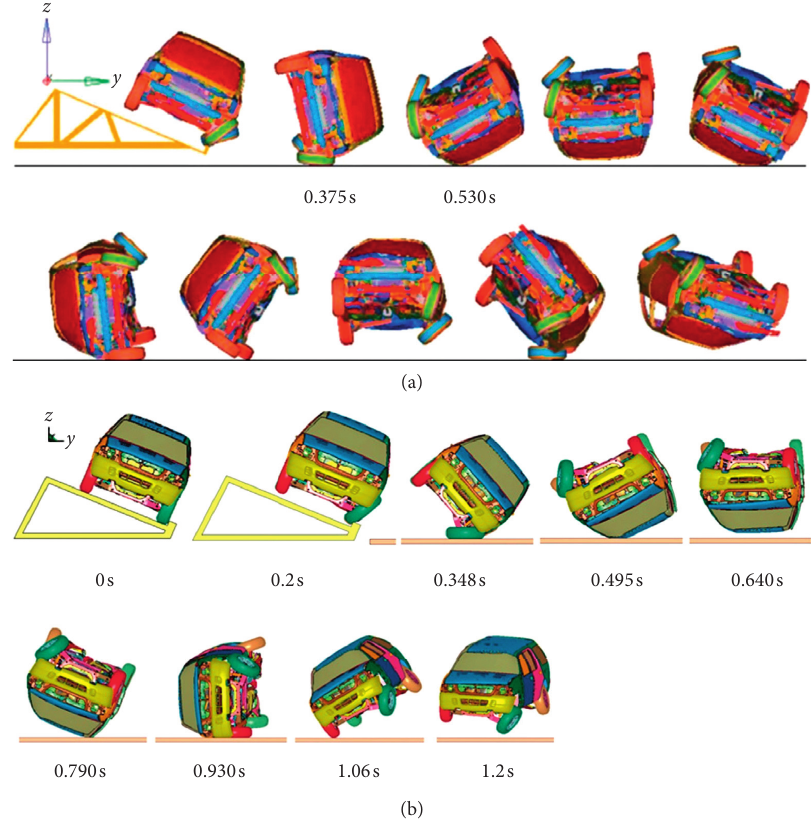
Figure 10: Dolly rollover: (a) de Lima and Marczak simulation; (b) Ford Explorer 2003